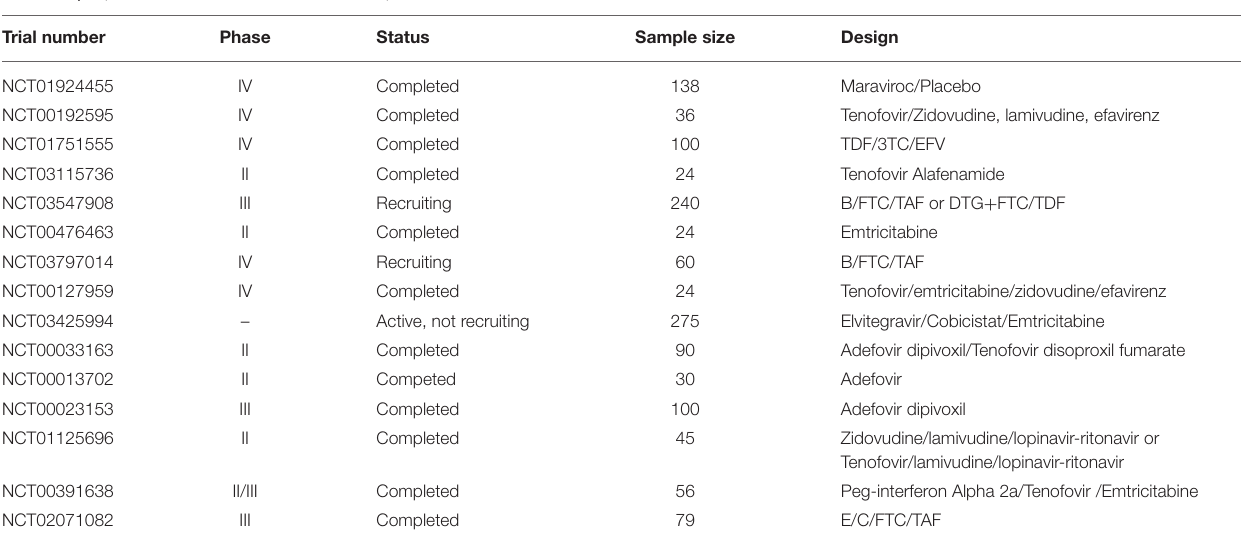
TABLE 2 | Important clinical trials of HIV/HBV